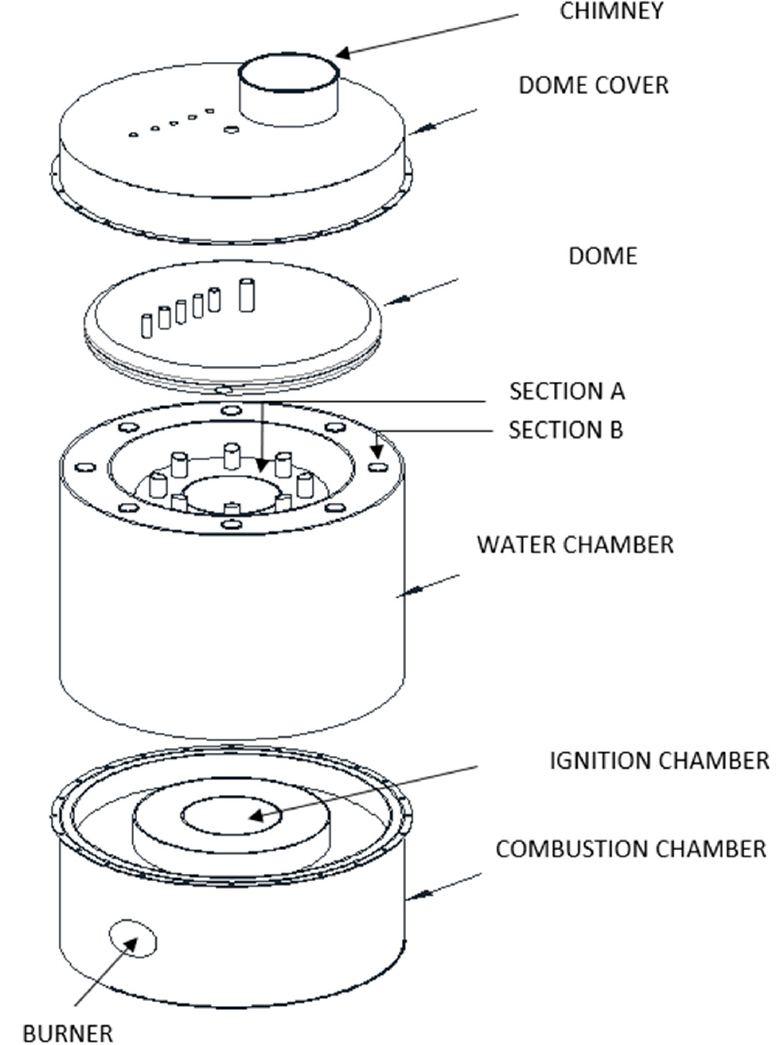
Figure 11. Components of the pyroacuotubular (mixed) boiler.